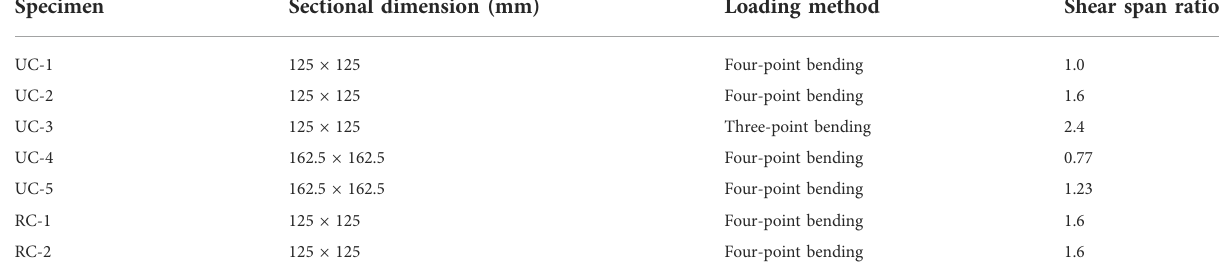
TABLE 4 Design parameters of